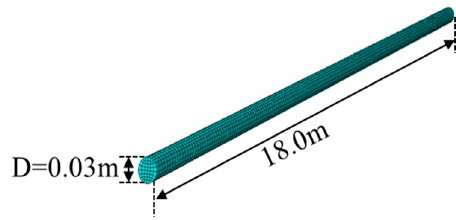
Figure 1. Explosive model